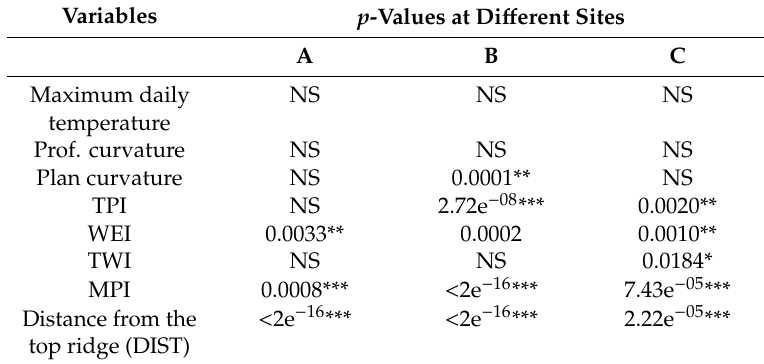
Table 5. Tested variables and their significance on juvenile height growth at the three sites.